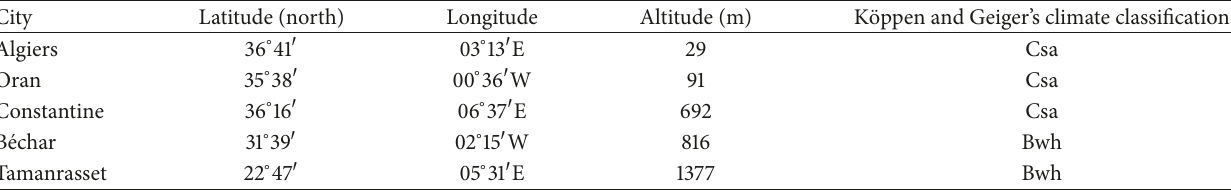
Table 2: Geographical coordinates and climate classification of the 5 cities according to K¨oppen-Geiger climate classification criteria [31]. City Latitude (north) Longitude Altitude